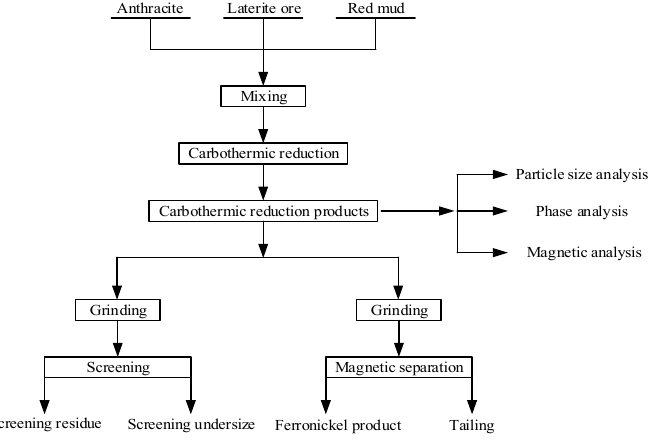
Figure 2. Process flowsheet.